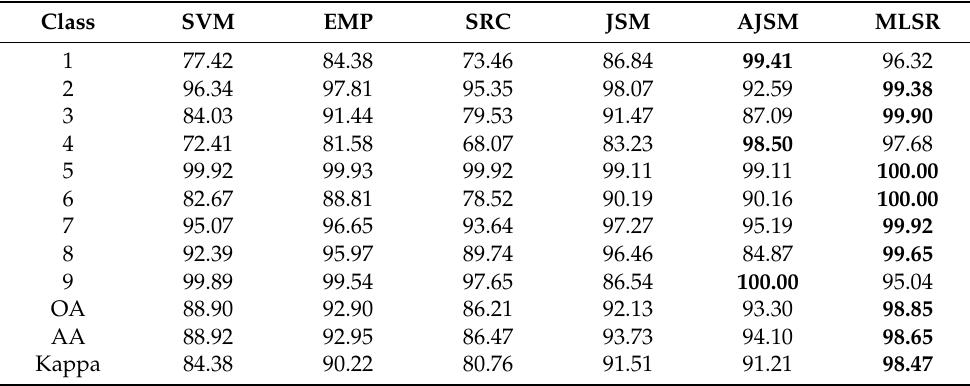
Table 4. Classification accuracies (%) for the University of Pavia image. The best results are shown in